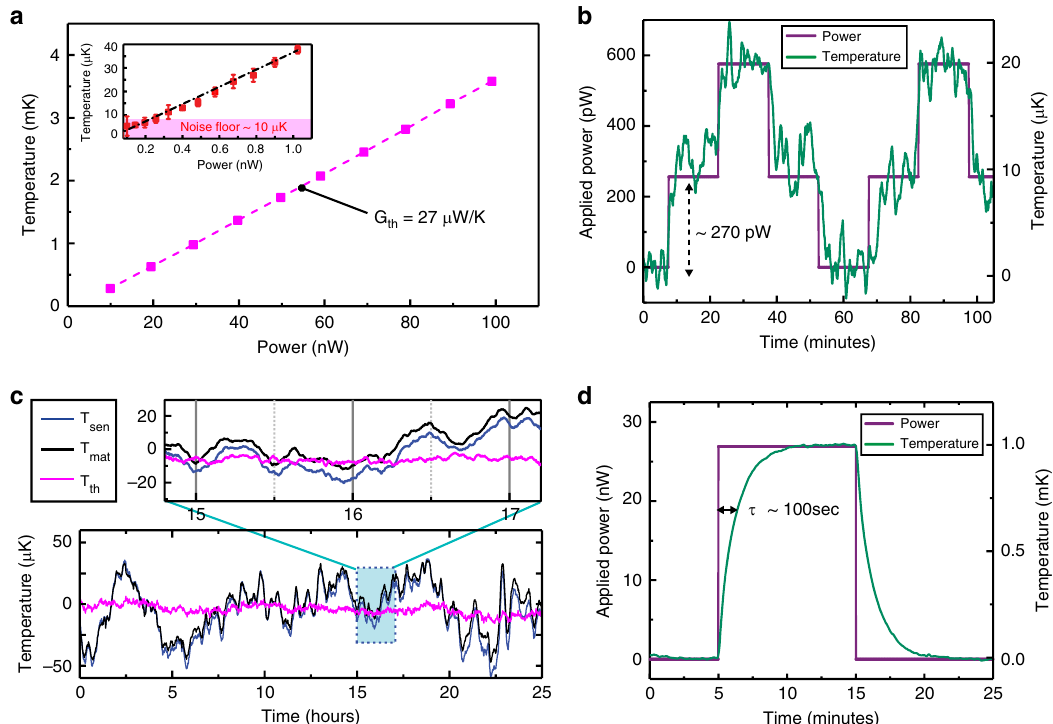
Fig. 2 Thermal characterization of the calorimeter. a Thermal conductance characterization ( G th ) performed at a fl ow rate of 100 nl min − 1 : temperature rise ( Δ T th ) of the center of the sensing capillary tube as a function of the DC power input is plotted, resulting in G th of ∼ 27 µ W K − 1 (magenta squares). The inset shows the temperature rise for sub-nW level inputs that result in a smaller temperature rise (0 – 40 µ K). The data represent the mean value of four different measurements and the error bars represent the standard deviation (±SD). From the observed standard deviation of (±5 µ K) we estimate a noise fl oor of ∼ 10 µ K. b Validation of thermal resolution. A thermal pulse (purple solid line) with steps of 270pW applied on the capillary (see Methods) resulted in a corresponding 10 µ K rise on the temperature signal (green solid line), validating our calorimeter ’ s capability to resolve at least 270 pW (heat resolution). c Temperatures of both the capillaries ( T mat in solid black, T sen in solid blue) without any sample in the sensing capillary tube are plotted for a 25-hour timespan, indicating fl uctuations of ±5 µ K in the differential signal ( T th in solid magenta). A 2 hour window (blue box) clearly shows that T mat follows T sen , indicating a common-mode radiative coupling to the outer shield. d Time constant of the sensing capillary tube. A square thermal pulse (purple solid line) in steps of ~27 nW results in a fi rst order temperature response with a time constant of ~1.5 min.